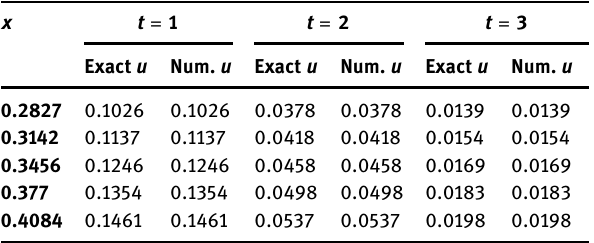
Table 3: Comparison of exact and numerical results of u at t = 1, 2, and 3 for = N 101 , = α 10 , = β 5 , = t Δ